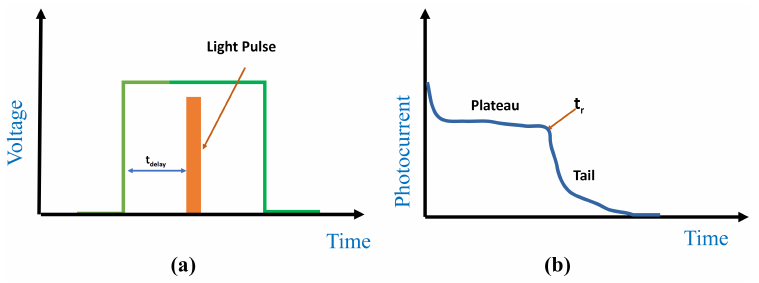
Figure 6. Time of flight technique ( a ) represents the inputs ( b ) represents the outputs